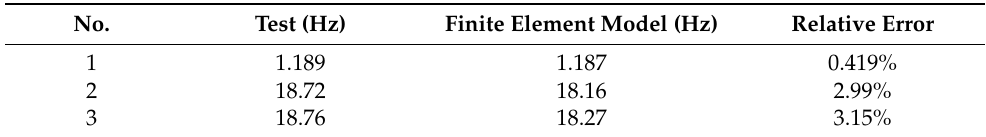
Table 4. Comparison of modal frequency .